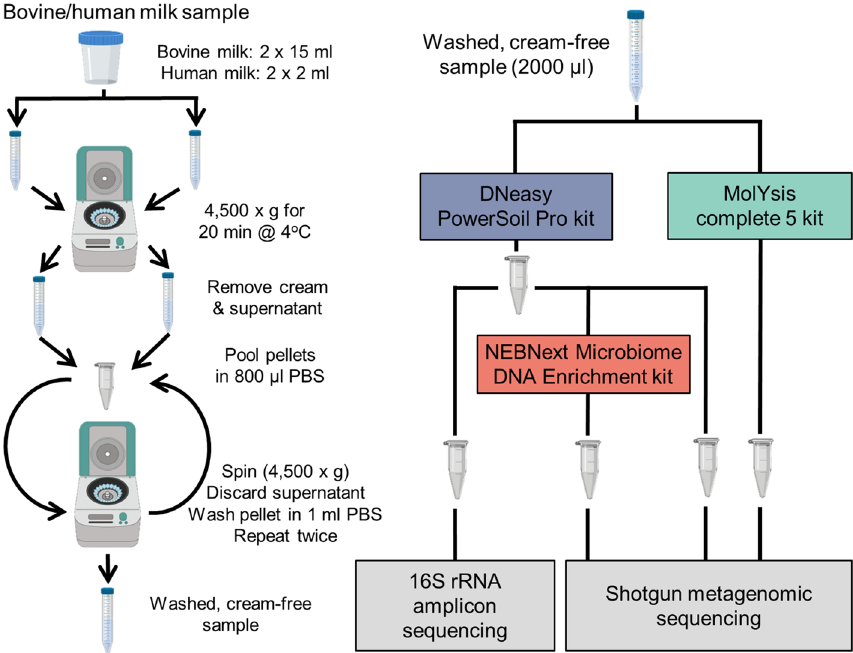
Figure 1. Experimental procedure used for the study. Process for skimming both bovine and human milk samples is indicated on the left. Direct extraction, host depletion, or microbial enrichment approaches are indicated on the right. This figure was created in part with